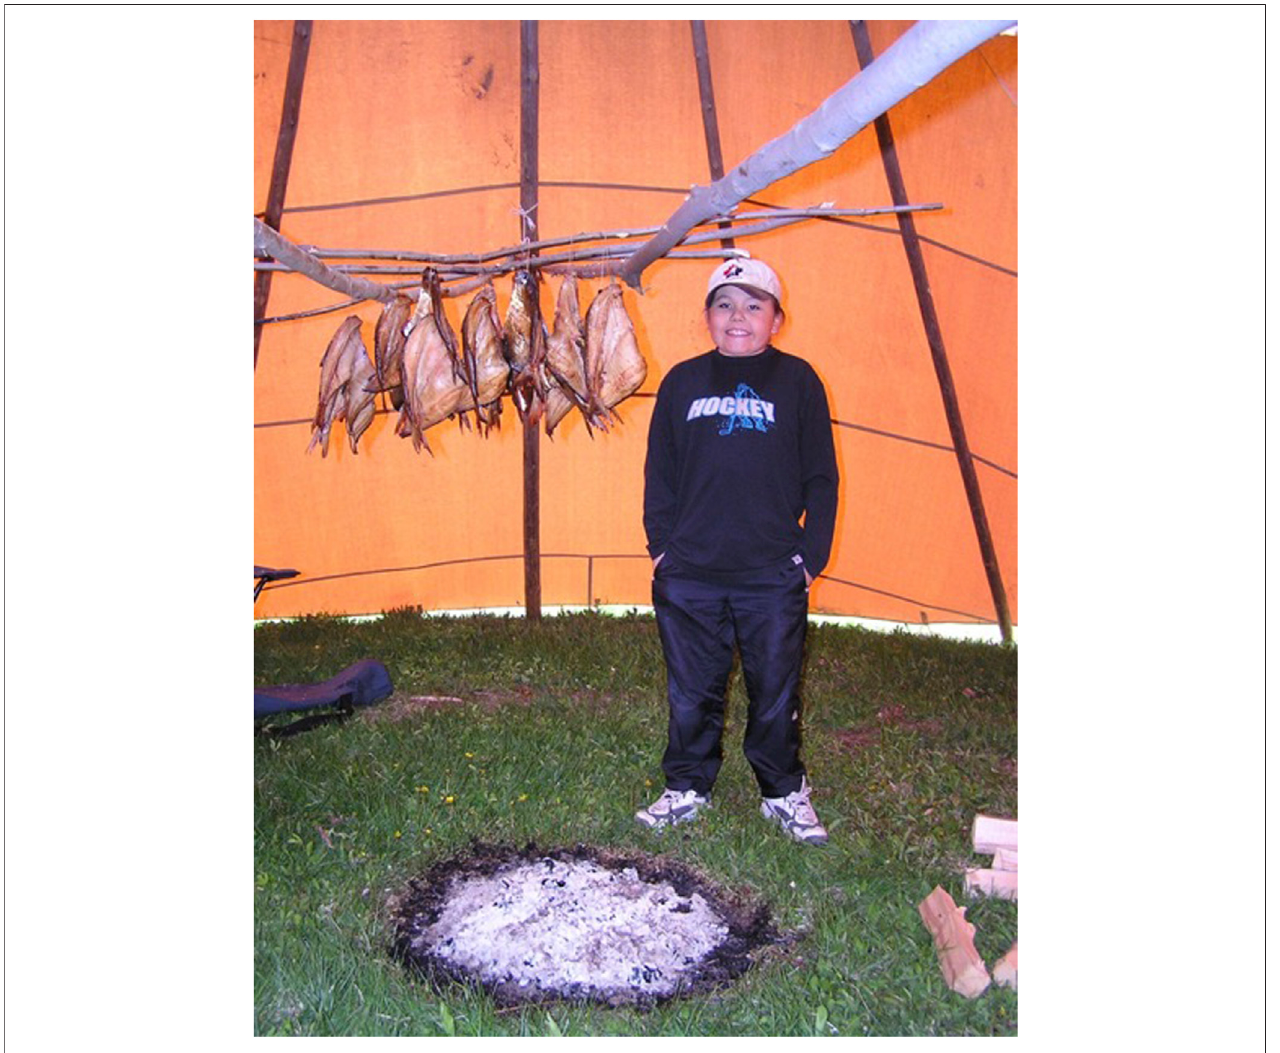
FIGURE 3 | Preserving fi sh in the smokehouse (photo credit: Sharla